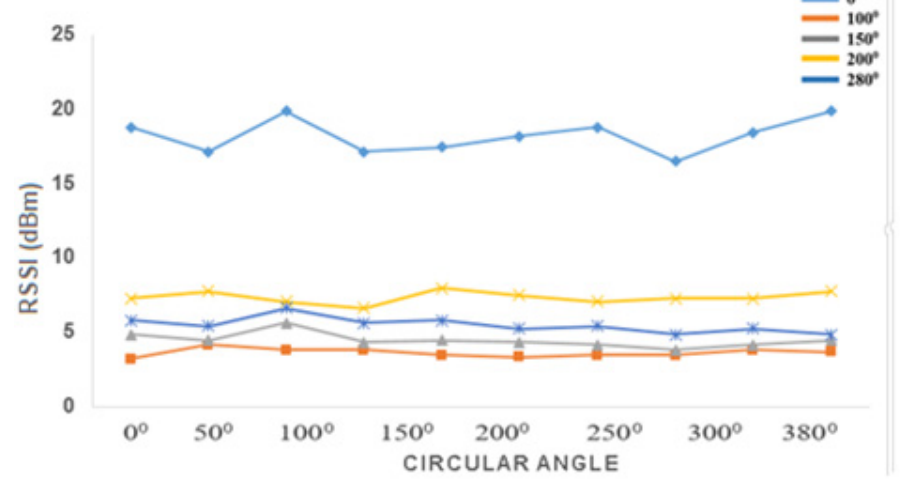
Figure 15. Dipole Antenna